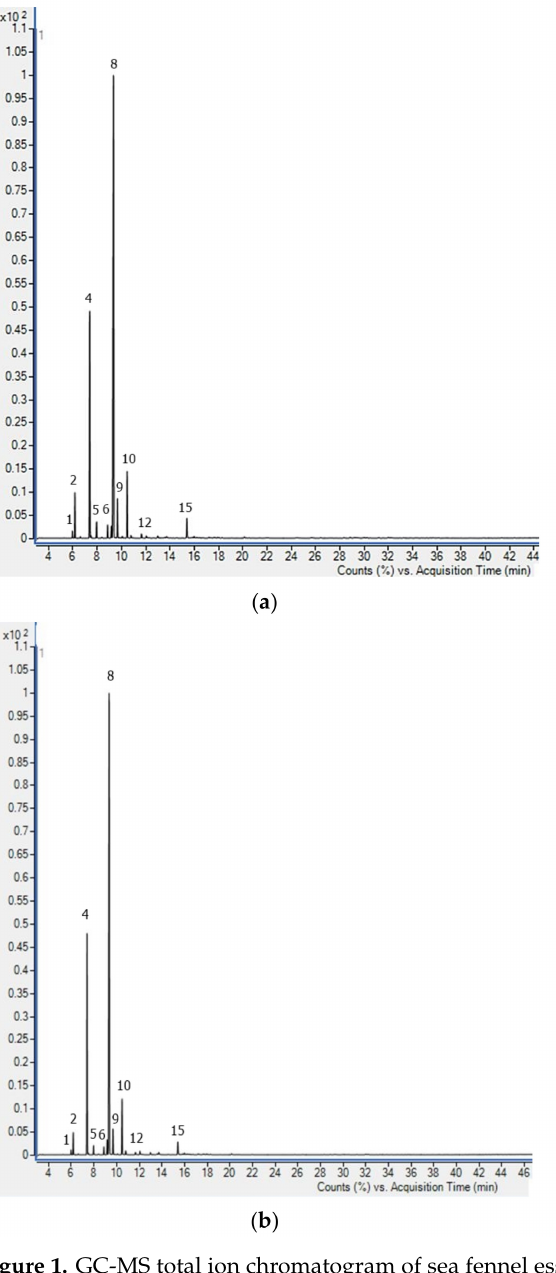
Figure 1. GC-MS total ion chromatogram of sea fennel essential oil obtained hydro-distillation ( a ) and microwave-assisted hydro-distillation ( b ). Peak assignment is given in Table